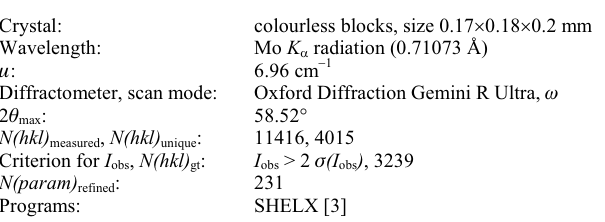
Table 1. Data collection and handling.